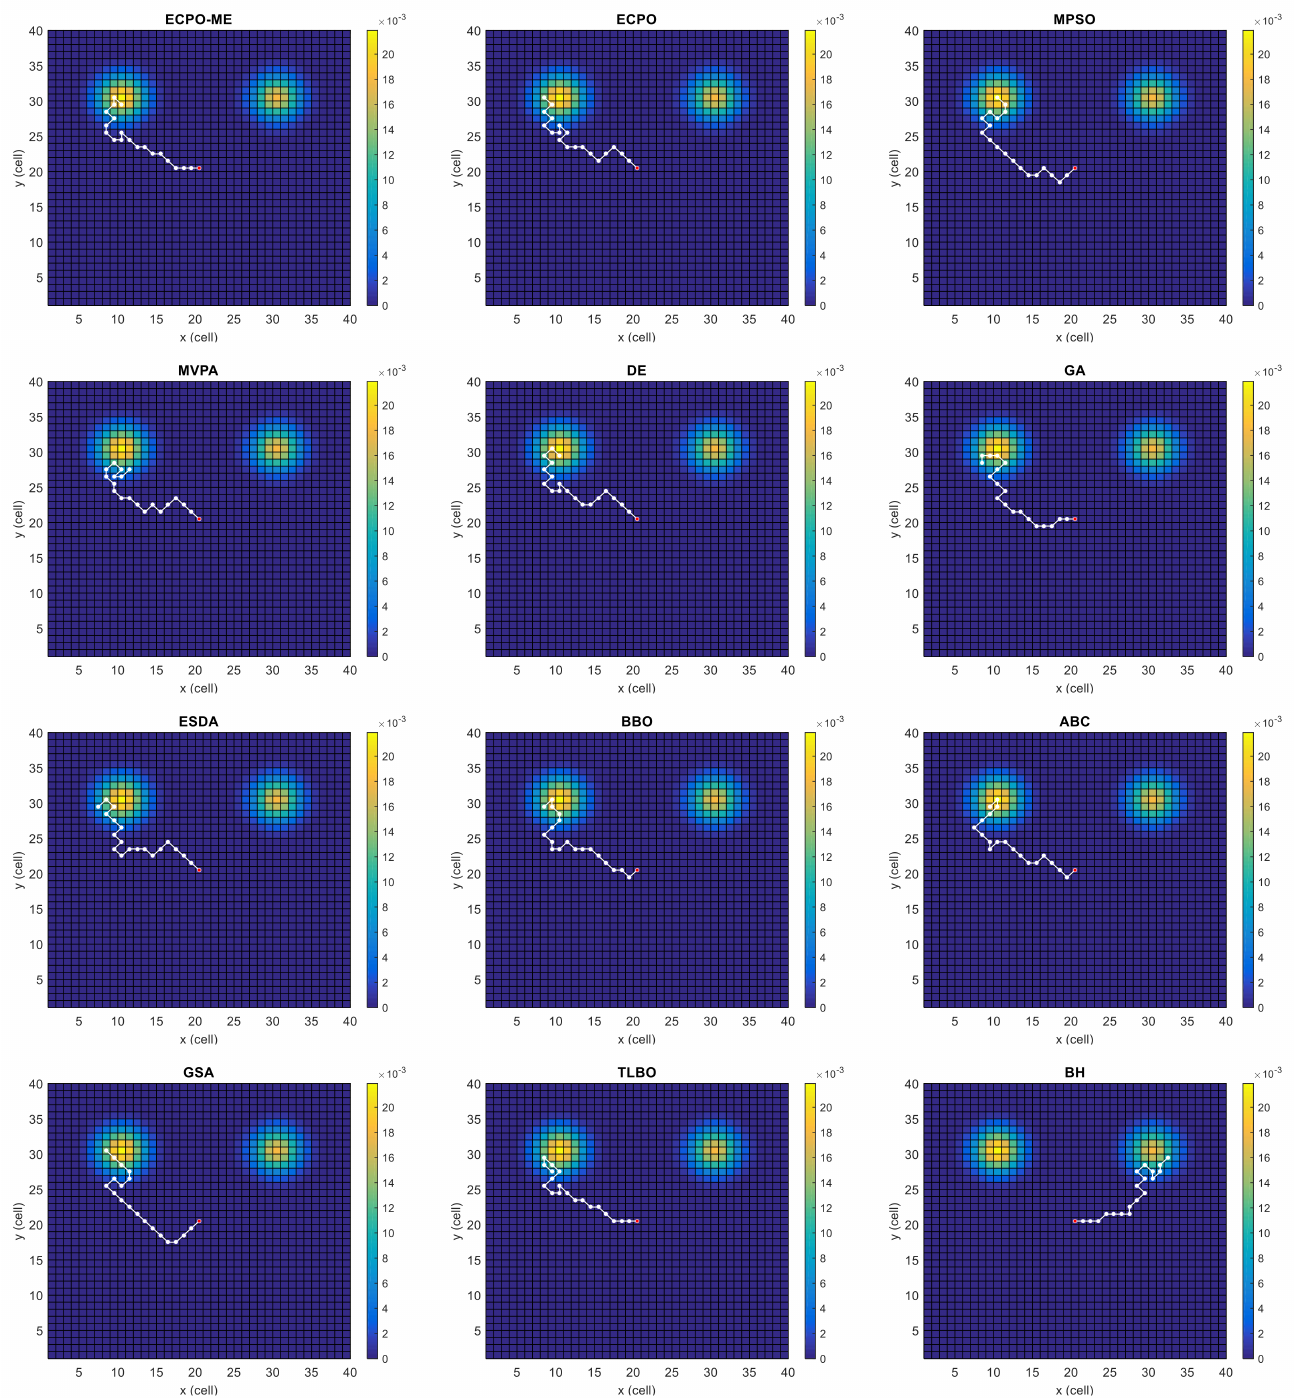
Figure 8. Search paths for Scenario E, obtained using the tested